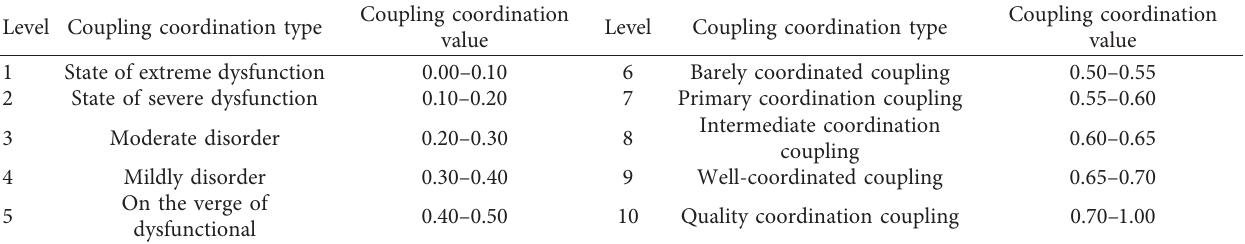
Table 3: Evaluation criteria for the degree of the coupled and coordinated development.